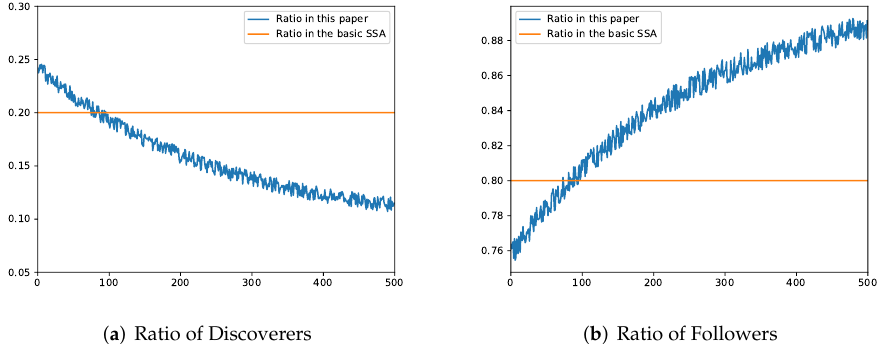
Figure 3. Changes in the ratio of discoverers and followers of CMASSA. Algorithm 1 provides pseudocode for